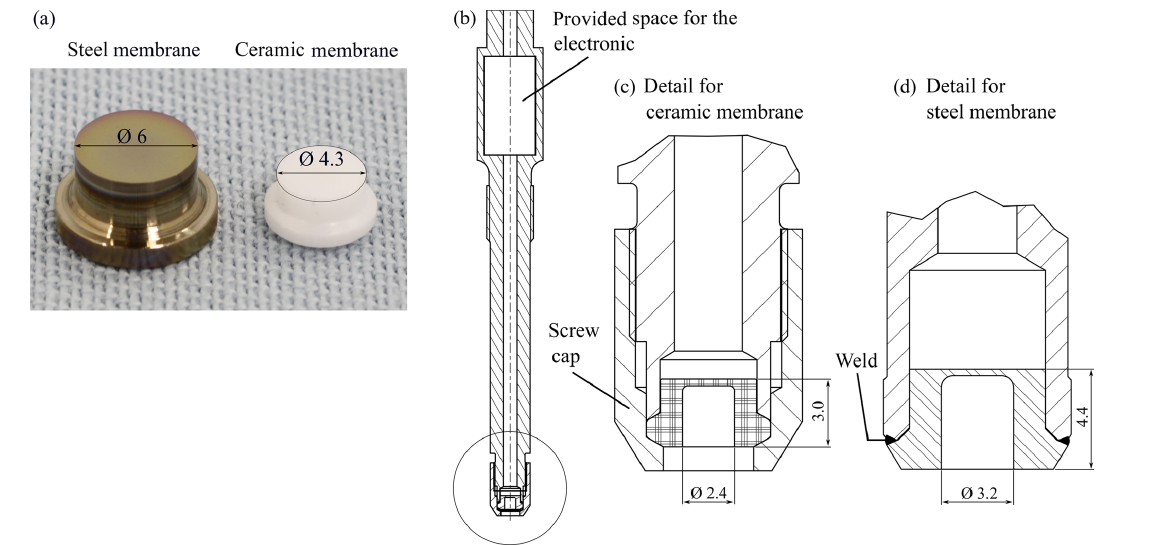
Figure 3. (a) Size comparison of the uncoated membranes. Sensor-housing (b) with appropriate types of attachment (c, d) for the different membrane versions. All dimensions in millimetres.